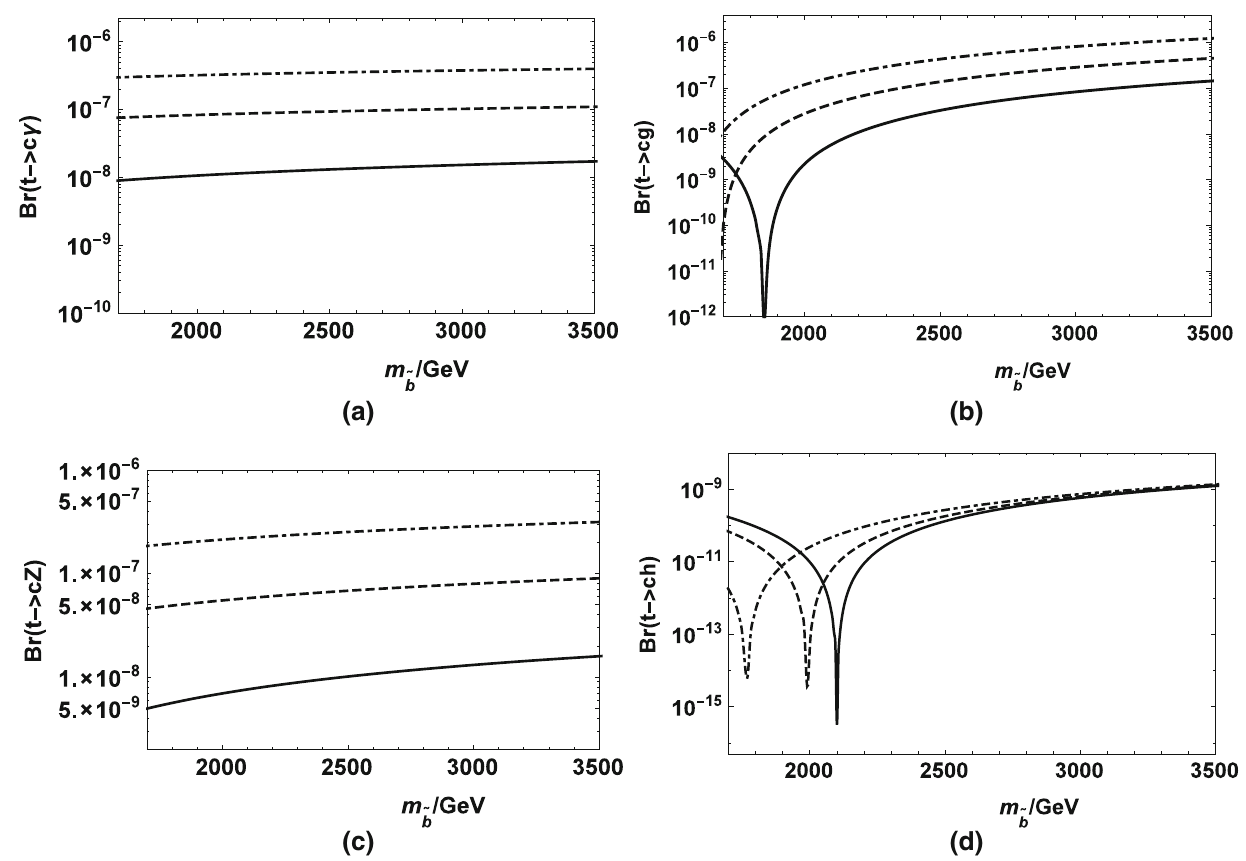
Fig. 3 Br ( t → c γ) ( a ), Br ( t → cg ) ( b ), Br ( t → cZ ) ( c ), Br ( t → ch ) ( d ) versus m ˜ 25 ( dashed line ), tan β = 35 (dot-dashed line) are